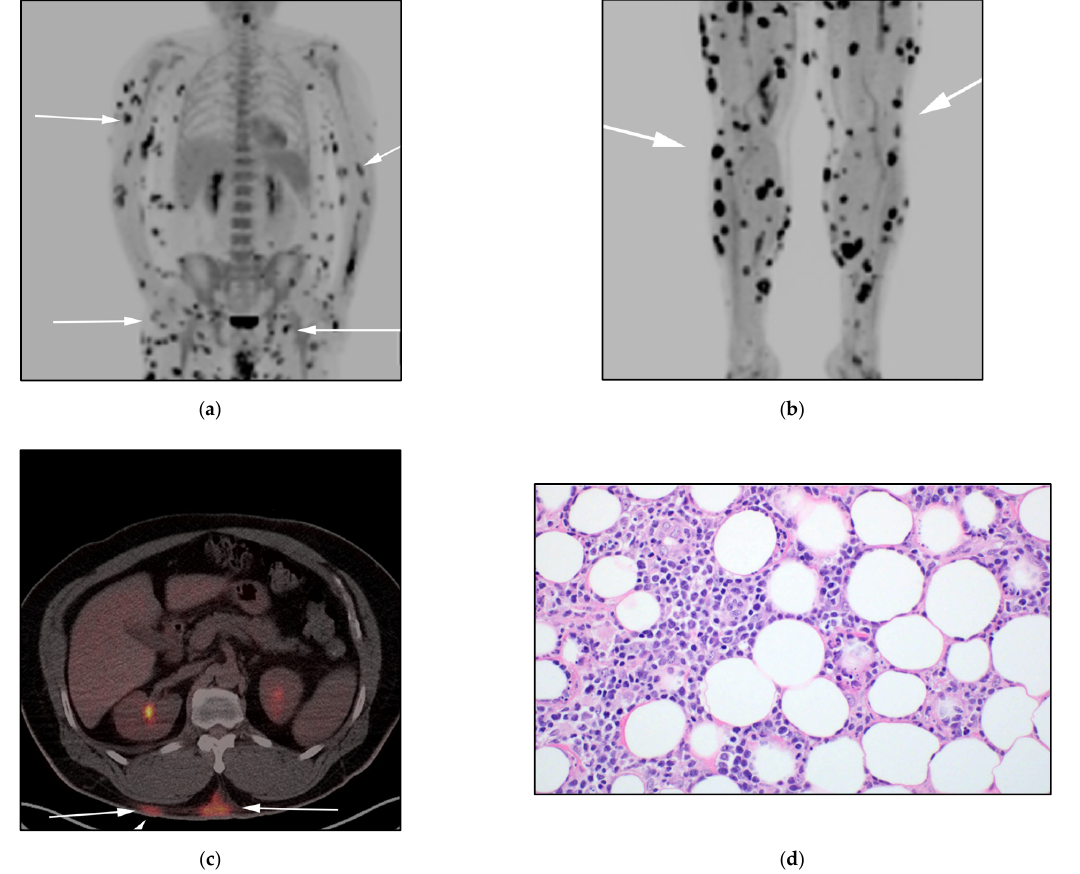
Figure 1. A 50-year-old-male presenting with multiple diffuse erythematous papules, biopsy revealed subcutaneous panniculitis T-cell lymphoma (STPCL). ( a , b ) F-18 FDG PET/CT maximal intensity projection (MIP) image, revealing extensive hypermetabolic cutaneous and subcutaneous lesions within the trunk as well as the limbs (white arrows). ( c ) F-18 FDG PET/CT axial, shows hypermetabolic nodular mass in the mid posterior abdominal wall (white arrows). ( d ) Histologic section from subcutaneous tissue shows monotonous medium-to-large neoplastic lymphoid cells encircling fat lobules in a lacelike distribution. The neoplastic cells show hyperchromatic nuclei. Note the vacuolated macrophages containing karyorrhectic debris. (Original magnification 400 × , H&E stain).